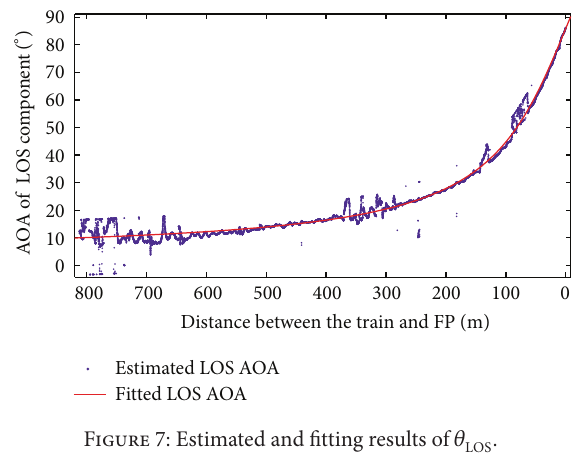
Figure 7: Estimated and fitting results of 𝜃